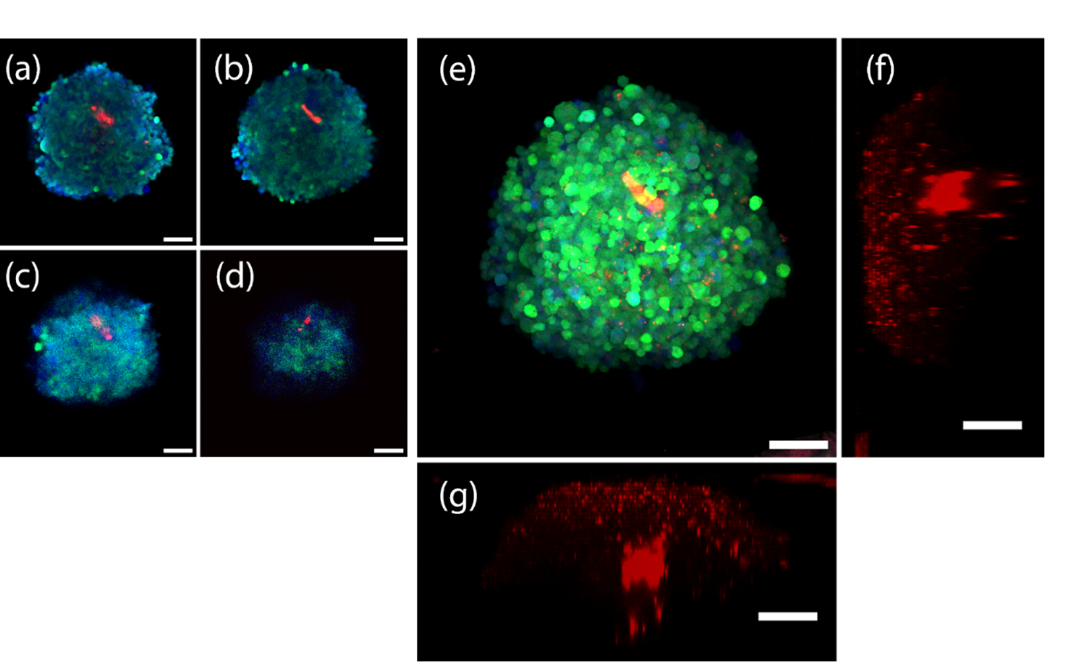
Figure 10. 10× confocal images (after clearing with HyClear, histogram ‐ adjusted) of a triculture spheroid of epithelial, fibroblast and endothelial cells, depicted by dGFP ( green ), CellTracker Blue (blue) and mCherry ( red ) colours, respectively. ( a – d ) are histogram adjusted z ‐ slices of the spheroid at ( a ) 150 μ m, ( b ) 200 μ m, ( c ) 250 μ m, and ( d ) 300 μ m. ( e ) depicts the maximum projection image of the spheroid. ( f , g ) depict the 3D projection of the spheroid (red channel only) from the Y and X axes, respectively. Scale bars represent 100 μ m.